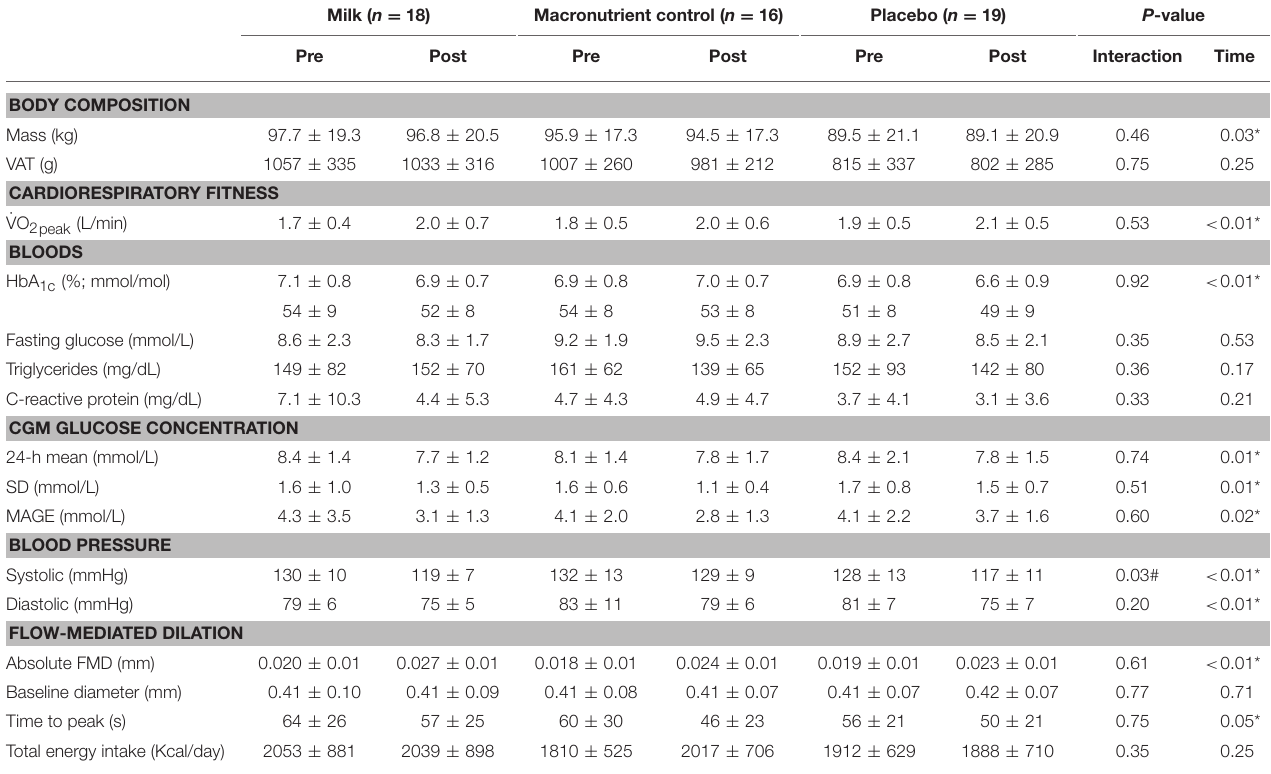
TABLE 2 | Body composition, cardiorespiratory fitness, blood pressure, flow-mediated dilation, triglycerides, C-reactive protein, and glycemic control measures before and after 12 weeks of HIIT and nutritional beverage. Milk ( n =